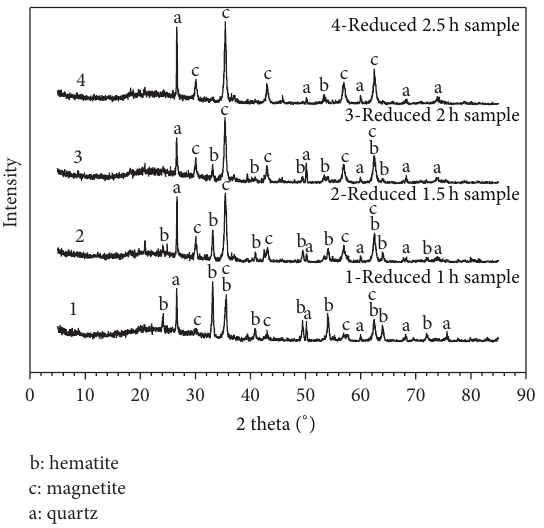
Figure 7: XRD patterns of samples reduced at 400 ∘ C.